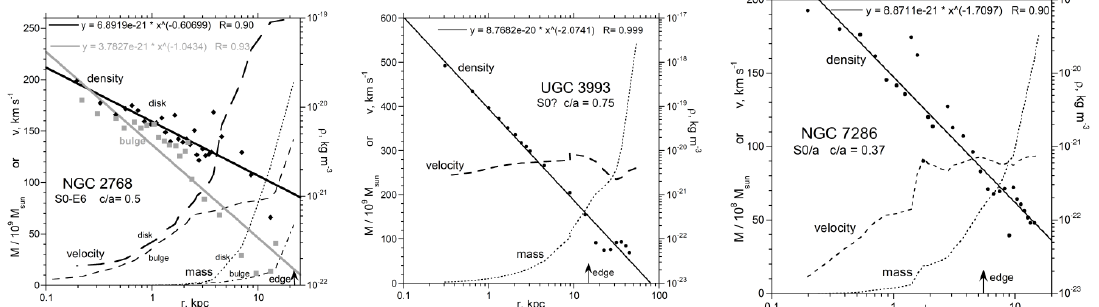
Figure A9. Lenticular galaxies. RCs of UGC 3993 and NGC 7786 from Noordemeer et al. [61]. RCs of NGC 2768 from Forbes et al. [42].